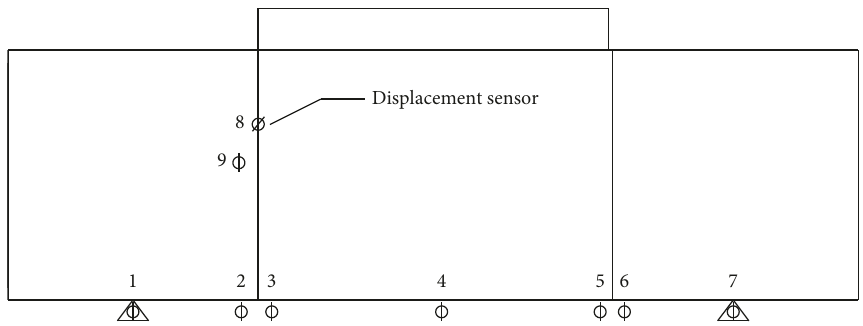
Figure 8: Layout of displacement sensors in the